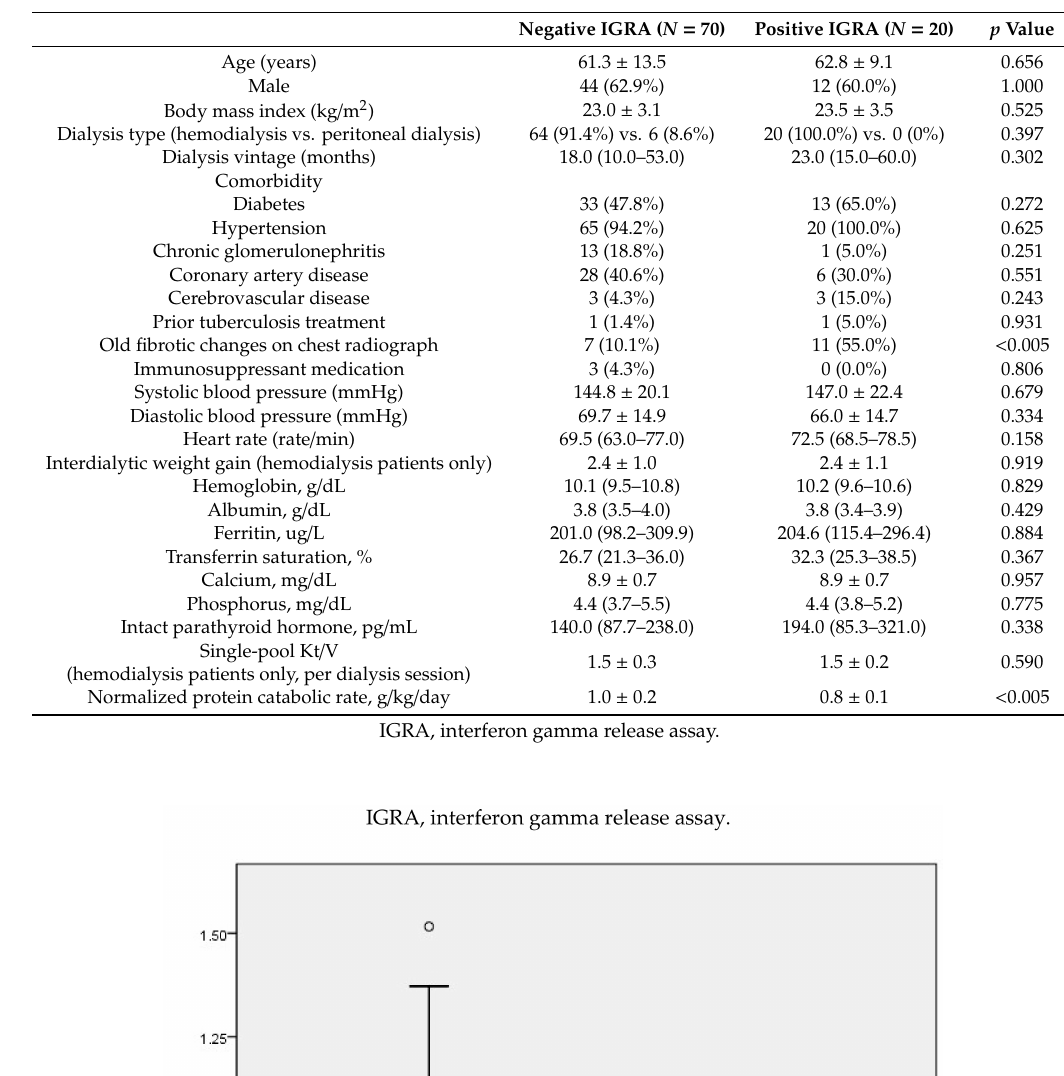
Table 1. Baseline characteristics of the groups according to interferon gamma release